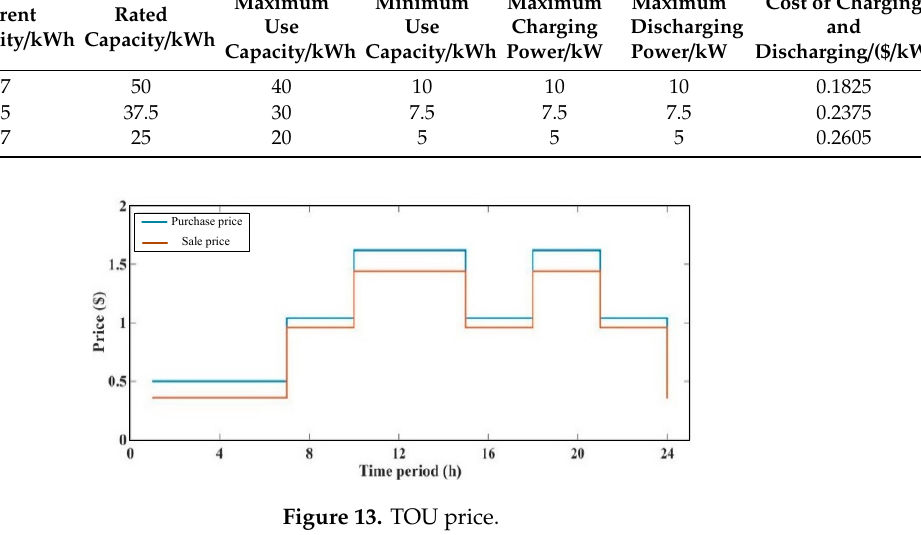
Table 9. The operation process in the Experiment